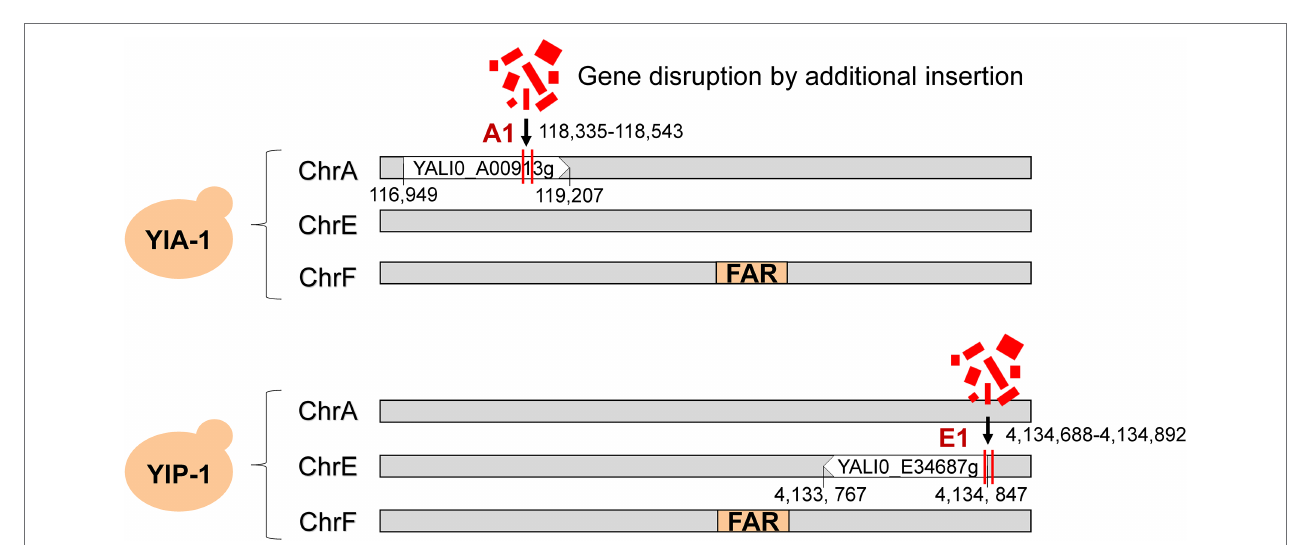
FIGURE 2 | Whole-genome sequencing determined gene disruption in fatty alcohol high-yielding strains. YlA and YlP strains were applied to the whole-genome sequencing. The FAR gene marked in orange was integrated into the chromosome F as expected. The gene disruption caused by the integration of broken vector fragments into chromosomes A and E was marked with red vertical line, named A1 and E1 sites, respectively. The A1 site was located in the 118,335–118,543 region of chromosomes A, and the E1 site was in the 4,134,688–4,134,892 region of chromosomes